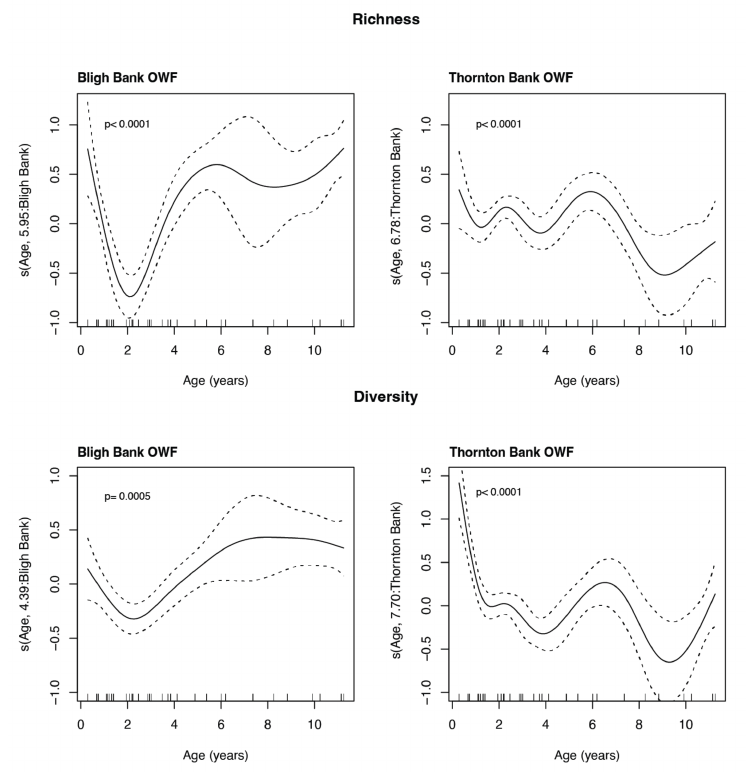
Figure 4. Fitted smoothing curves for ‘age’ in the best-fitting generalized additive model explaining richness and diversity patterns at the Bligh Bank and Thornton Bank offshore wind farms.